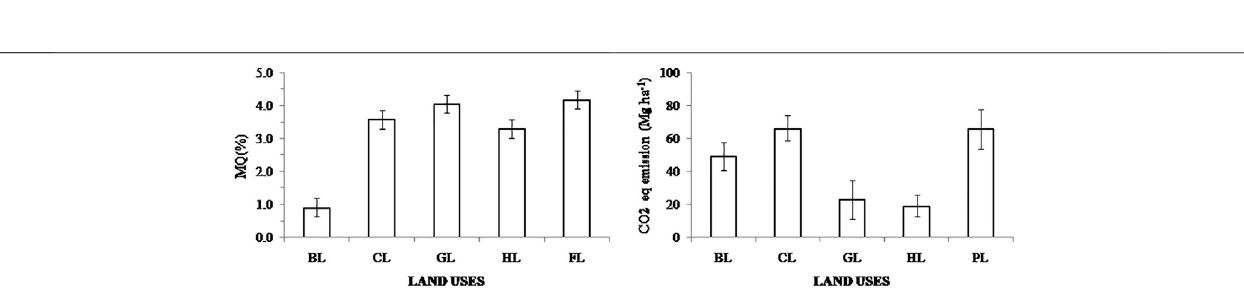
FIGURE6| Comparisonsofsoilcarbonstocks(SOCstocks)undervarious landuses(BL,CL, GL,HL,and PL)withFLbasedonsoildepths(0 – 15 cm,15 – 30 cm, and 30 – 45 cm). The error bars show 95% con fi dence intervals (CI) and the difference is signi fi cant if it does not pass zero. *indicates signi fi cant difference at p -value is less than 0.05. Here, Forest land (FL) is used as control, BL — Barren land, CL — Cultivated land, GL — Grassland, HL — Horticulture land, and PL — Plantation land.